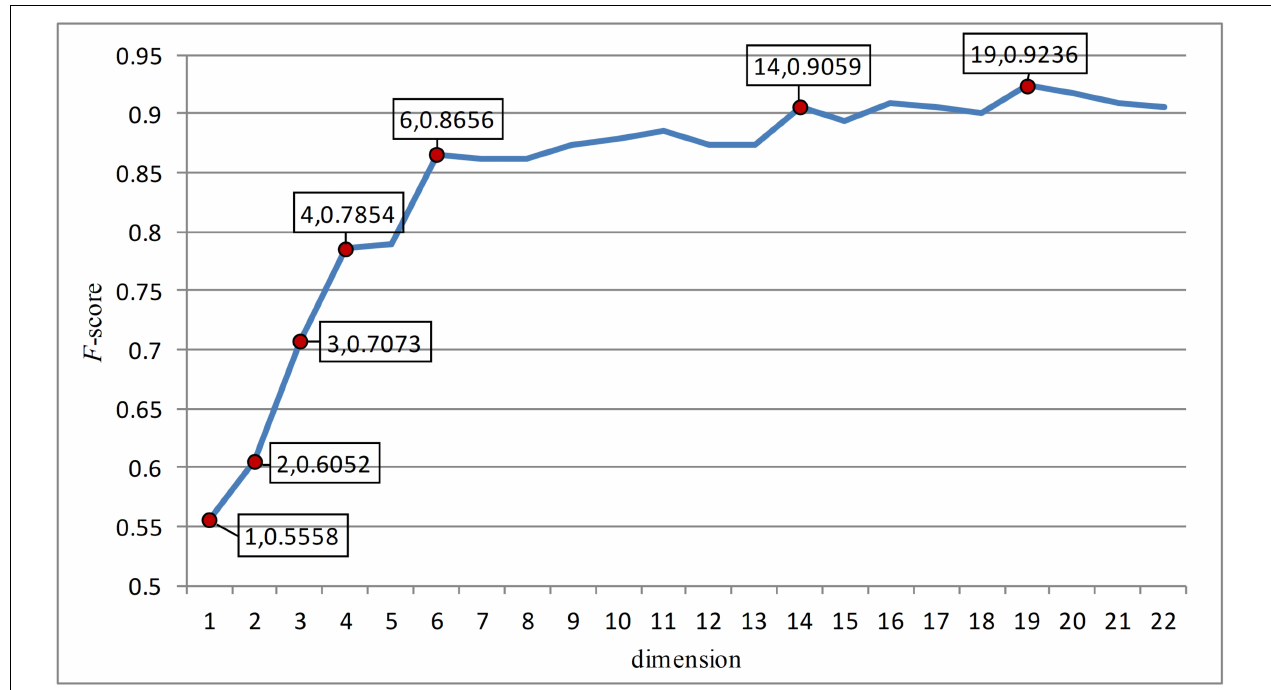
FIGURE 3 | The figure was the change of F-score with dimension according to the last dimension reduction. The red dots in the figure were the feature points with great changes in this paper. And these points were separated to form a new feature model and verified. After verification, these seven red dots are the most important seven